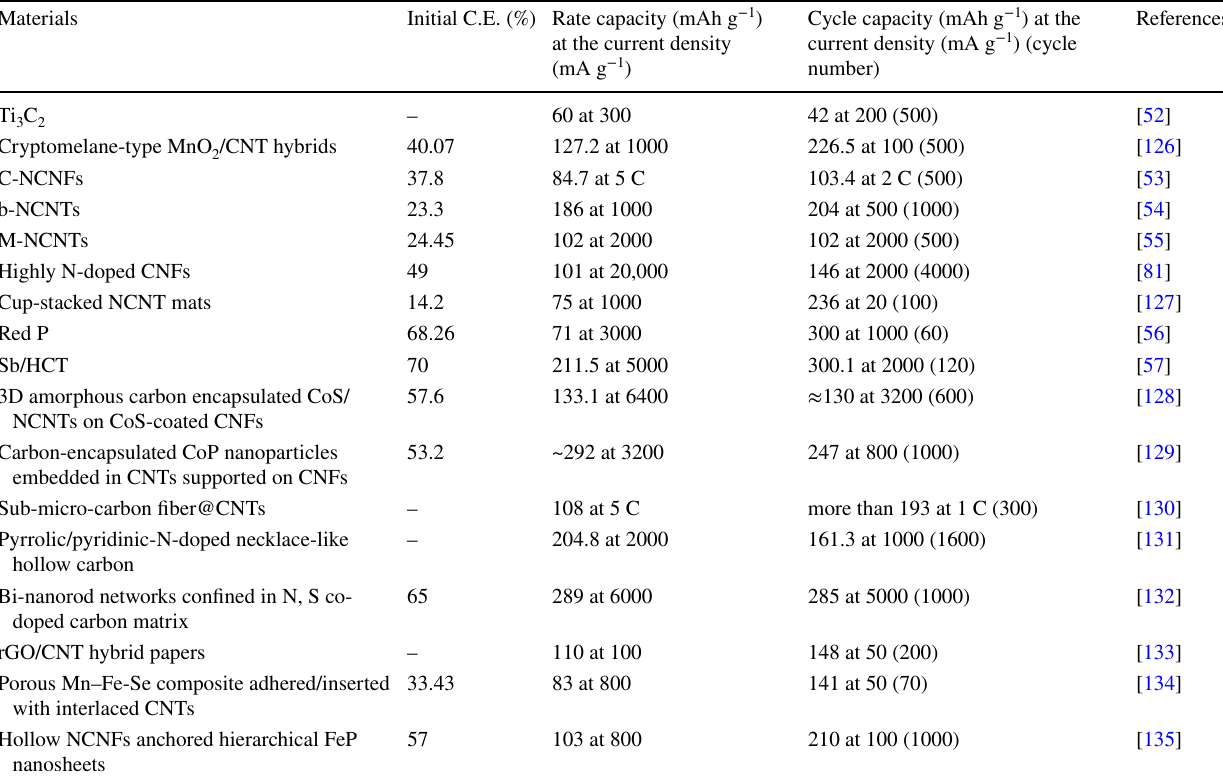
Table 2 Comparison of state-of-the-art performances of 1D anode materials in PIBs